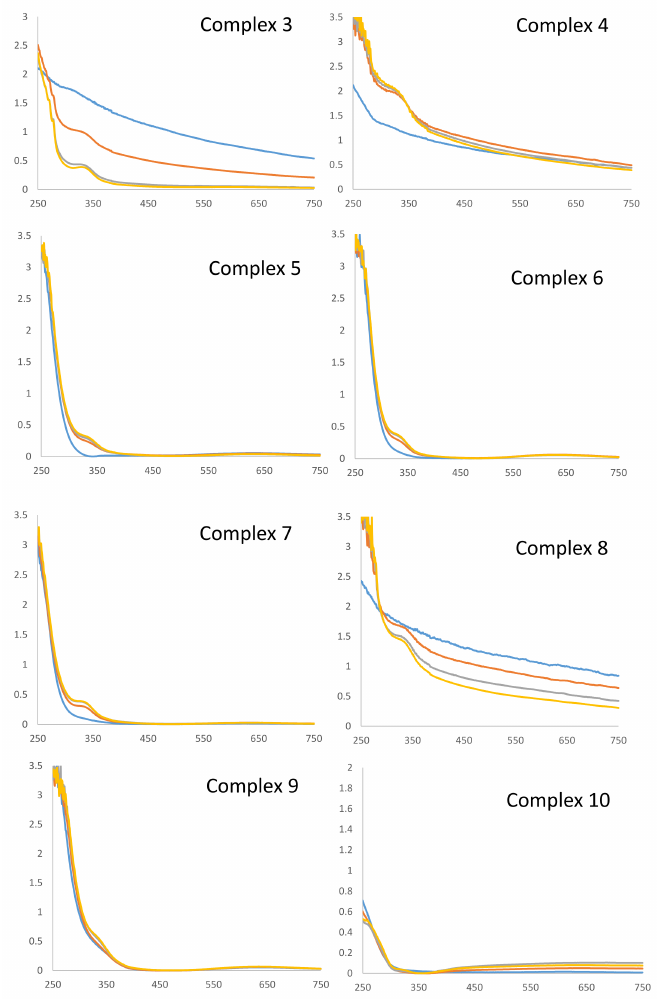
Figure 7. Stability studies. All complexes were dissolved at 50 µ M in 0.5% DMSO/RPMI. UV-Vis spectra were recorded at t = 0 min (yellow), t = 24 h (grey), t = 48 (red), and t = 72 h (blue), at 37 ◦